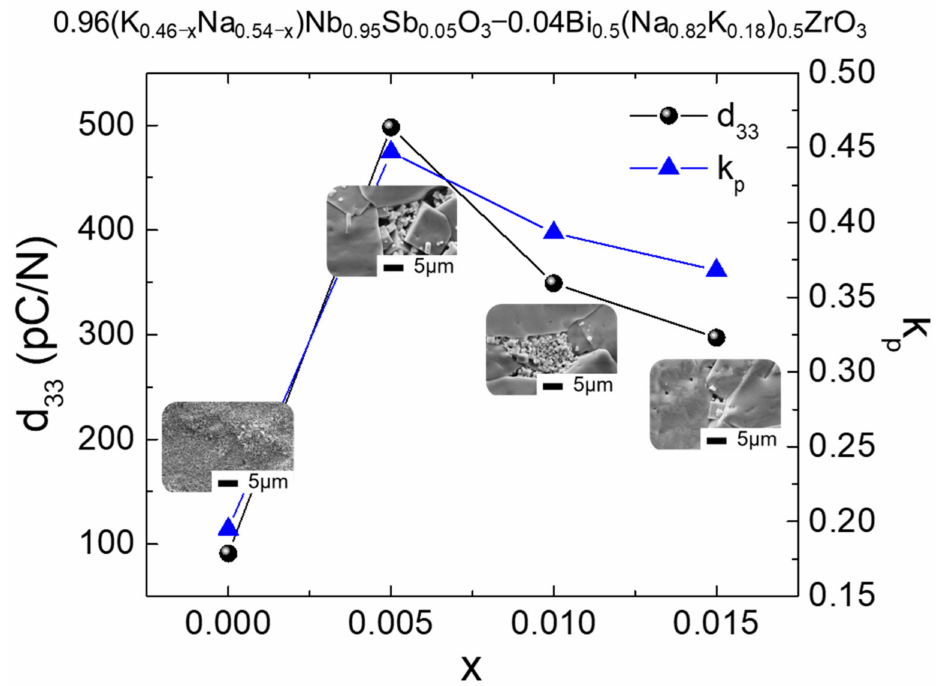
Figure 3. Piezoelectric charge coefficient (d 33 ) and electromechanical coupling coefficient (k p ) of 0.96(K 0.46 − x Na 0.54 − x )Nb 0.95 Sb 0.05 O 3 -0.04Bi 0.5 (Na 0.82 K 0.18 ) 0.5 ZrO 3 ceramics sintered at 1085 ◦ C for 4 h. The 0.96(K 0.46 − x Na 0.54 − x )Nb 0.95 Sb 0.05 O 3 -0.04Bi 0.5 (Na 0.82 K 0.18 ) 0.5 ZrO 3 ceramics